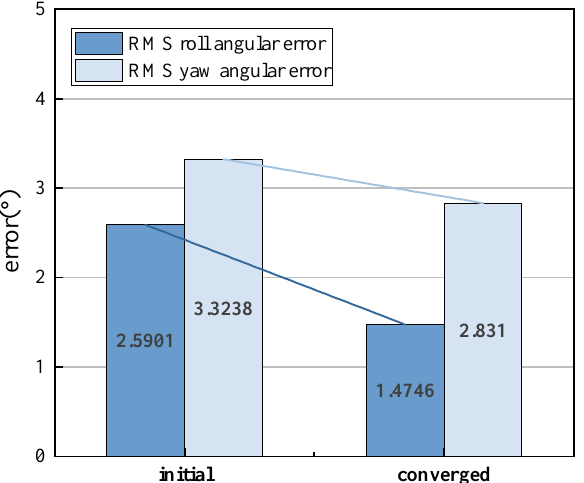
Figure 9. Flight results of the adaptive attitude and altitude controller. The dashed lines are the control references. ( a ) Flight results of attitude control. ( b ) The adaptation of bias torque estimators. ( c ) Flight results of altitude control. ( d ) The adaptation of mass estimator.